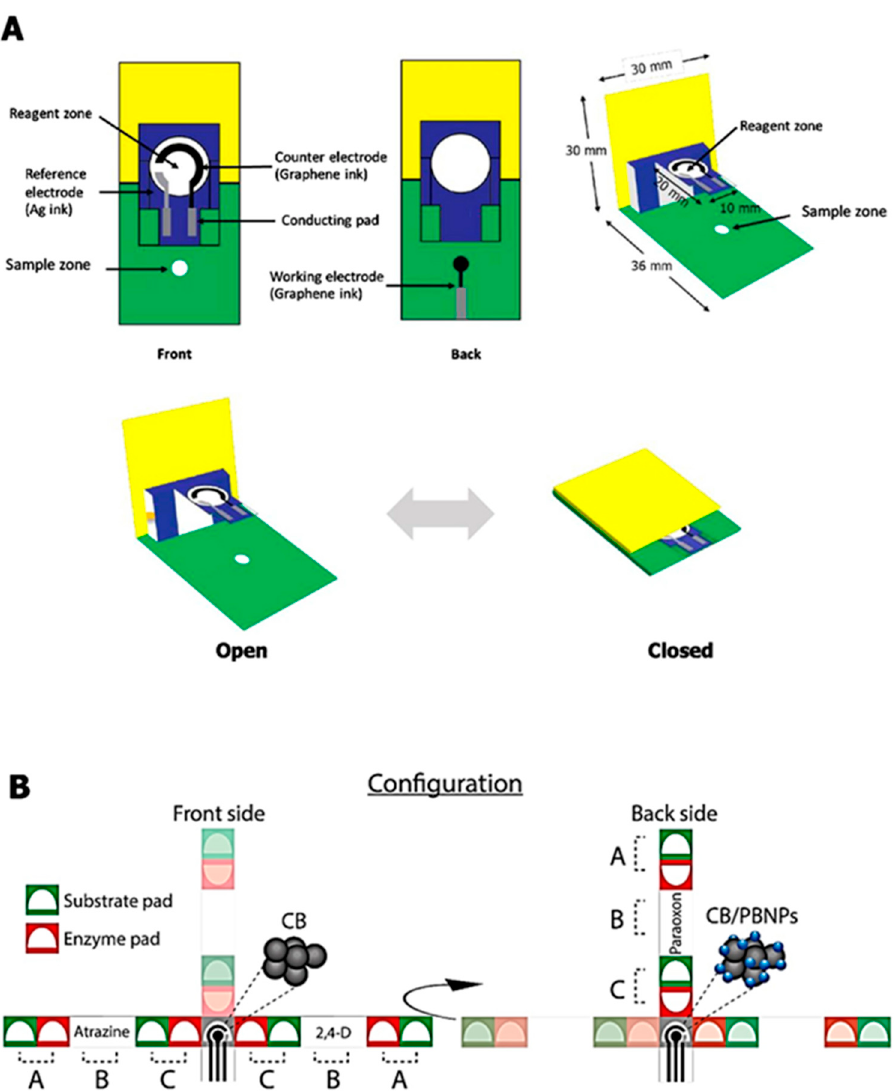
Figure 2. Examples of e-PADs with 3D design, ( A ) the pop-up DNA biosensor design and its oper- ation, adapted from [50], and ( B ) the 3D-origami enzyme biosensors with their measurement steps [14].